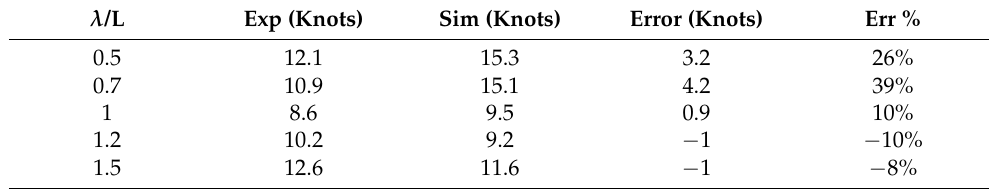
Table 1. Comparison of experimental and numerical speed reduction in waves for